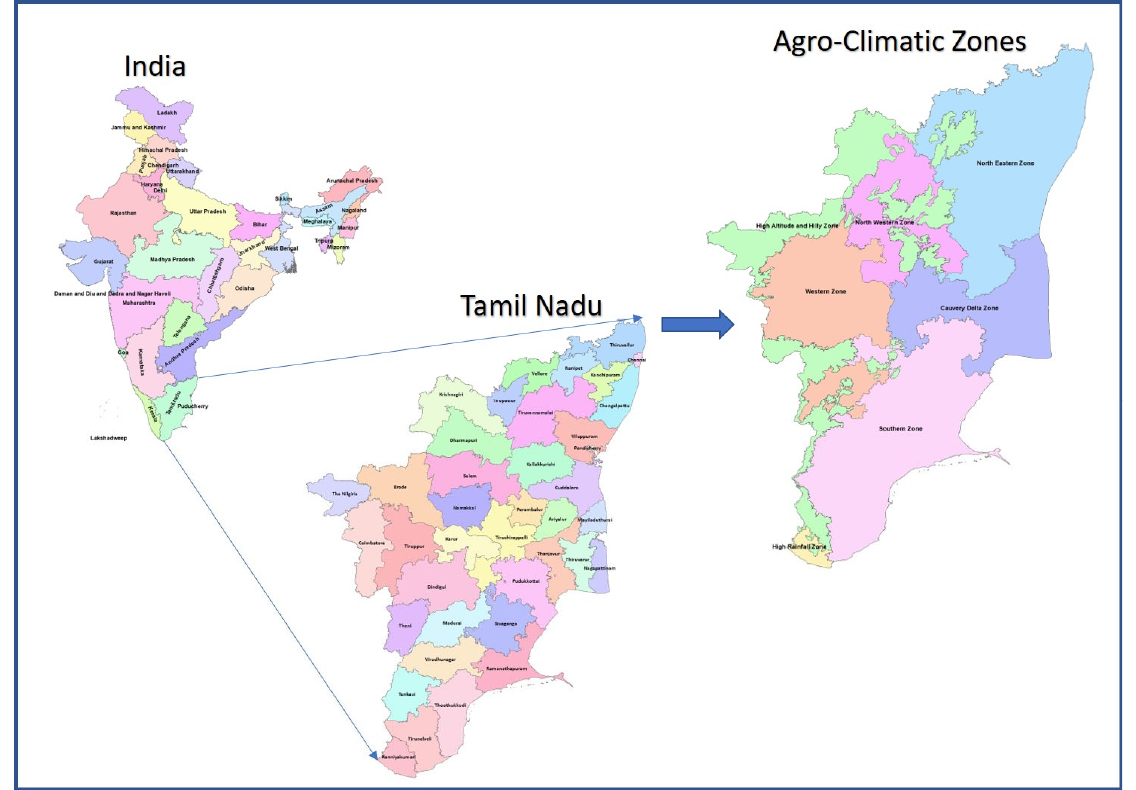
Figure 1. The study area of Tamil Nadu with seven agro-climatic zones.